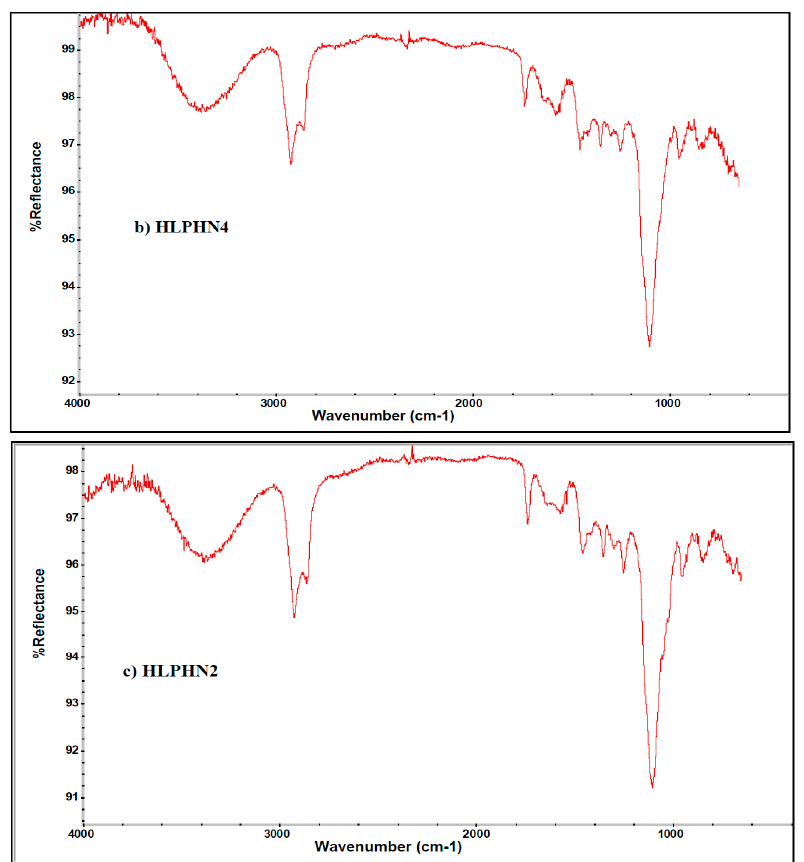
Figure 4. FTIR spectral analysis of ( a ) hesperidin ( b ) HLPHN4 ( c ) HLPHN2 under the optimized conditions.